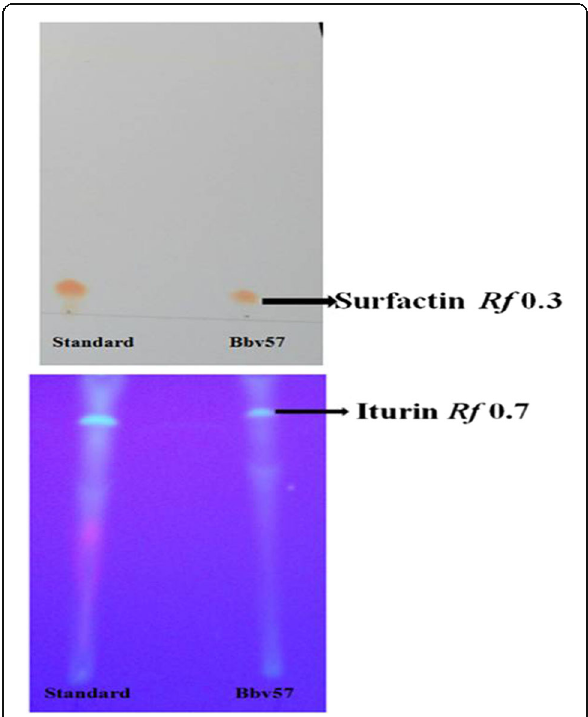
Fig. 3 Detection of iturin and surfactin in B. subtilis Bbv 57 through